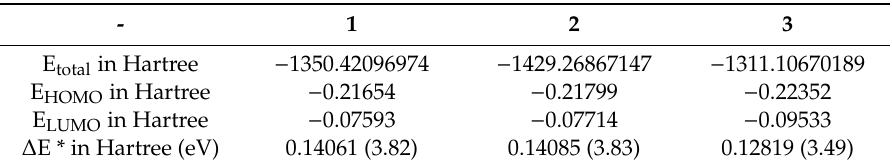
Table 5. Total energy and frontier orbital energy.